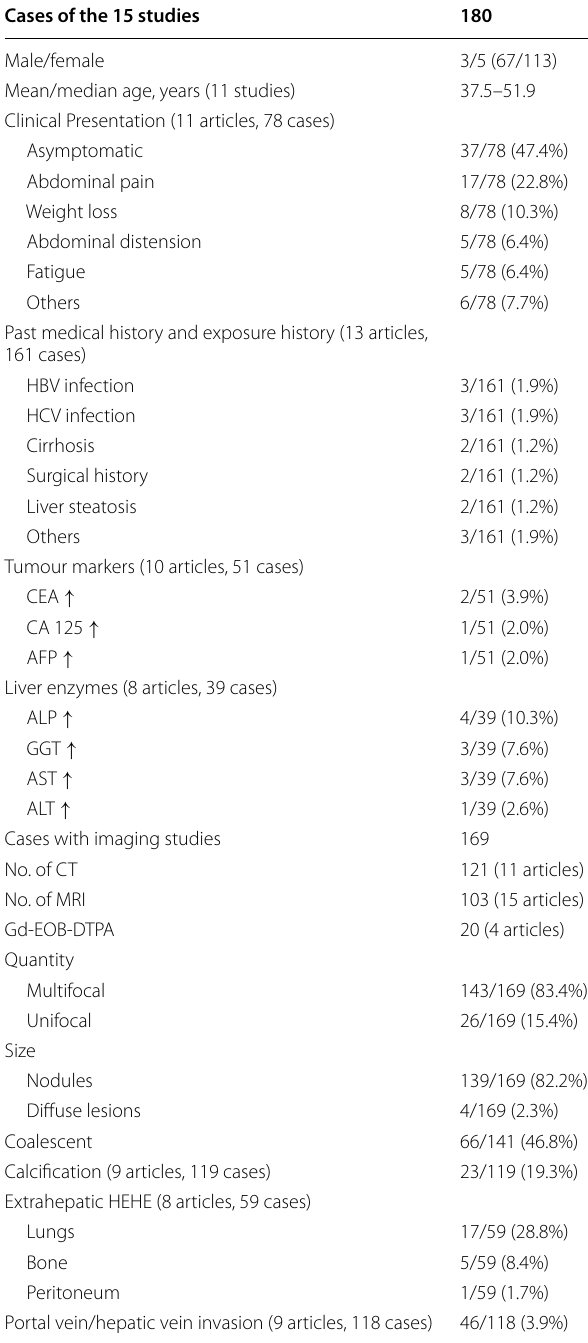
Table 2 Summary of clinical and general imaging characteristics of literature